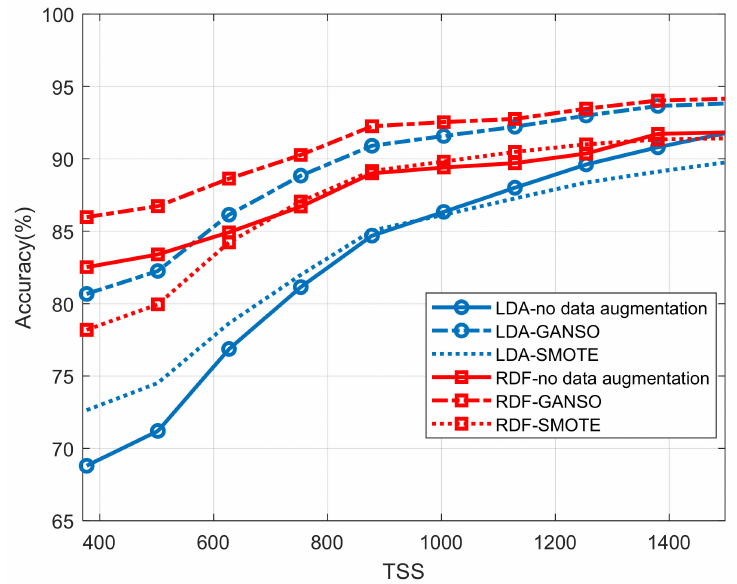
Figure 3. Variation of the accuracy for different values of the training set size ( TSS